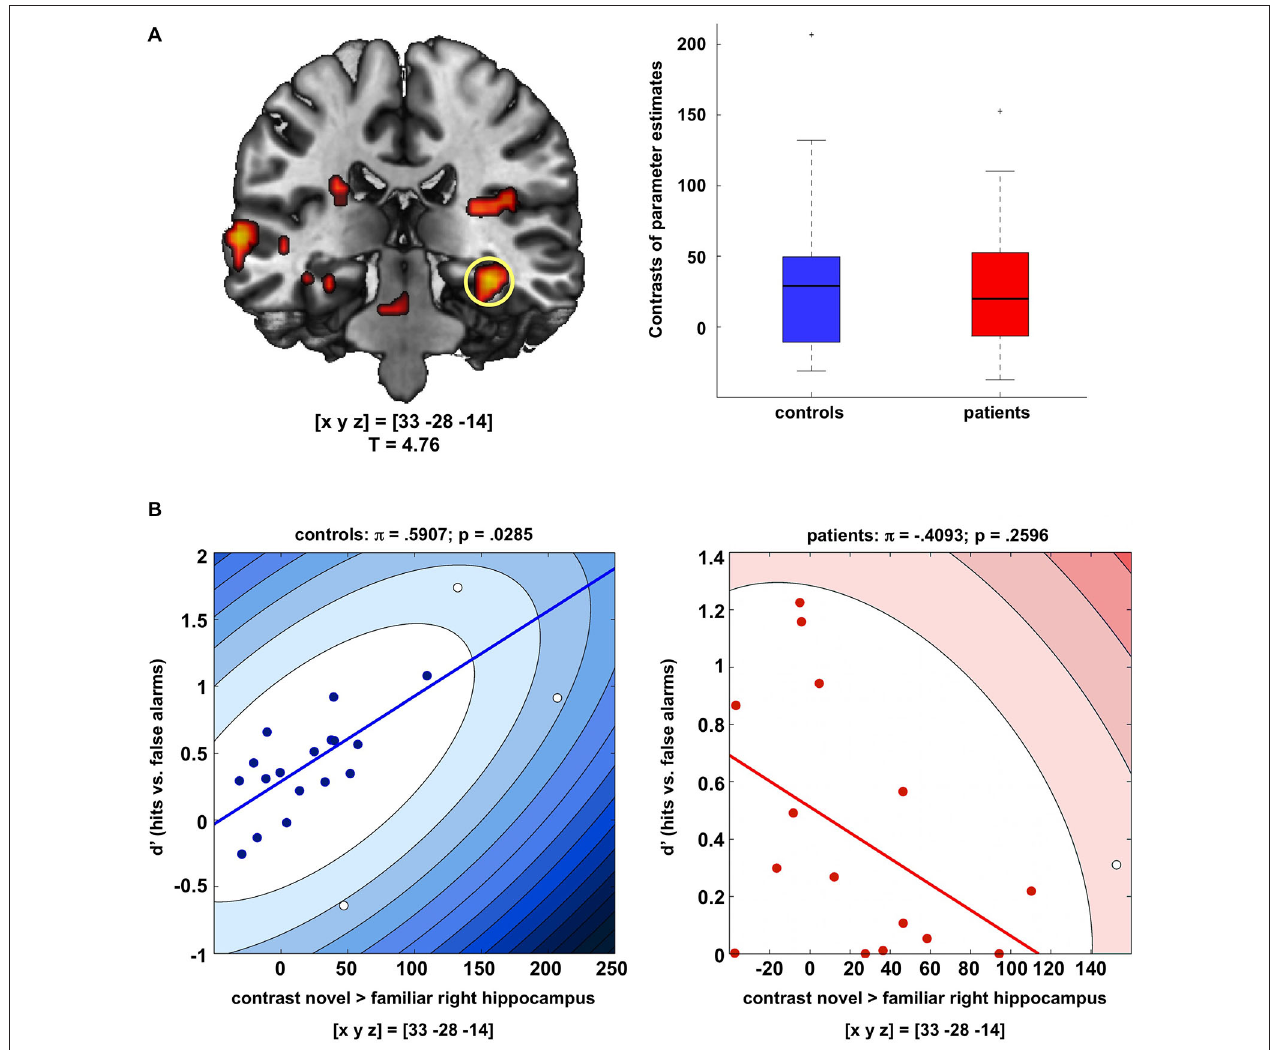
p < 0.005, uncorrected, for illustrative purpose only. (B) In the healthy controls, hippocampal activation to novel images was positively correlated with successful recognition of the images after 24 h (d’ values, adjusted in participants with false alarm rates of 0), whereas no significant correlation was observed in the patients. Scatter plots depict Shepherd’s pi correlations, separately for controls (left) and patients (right).